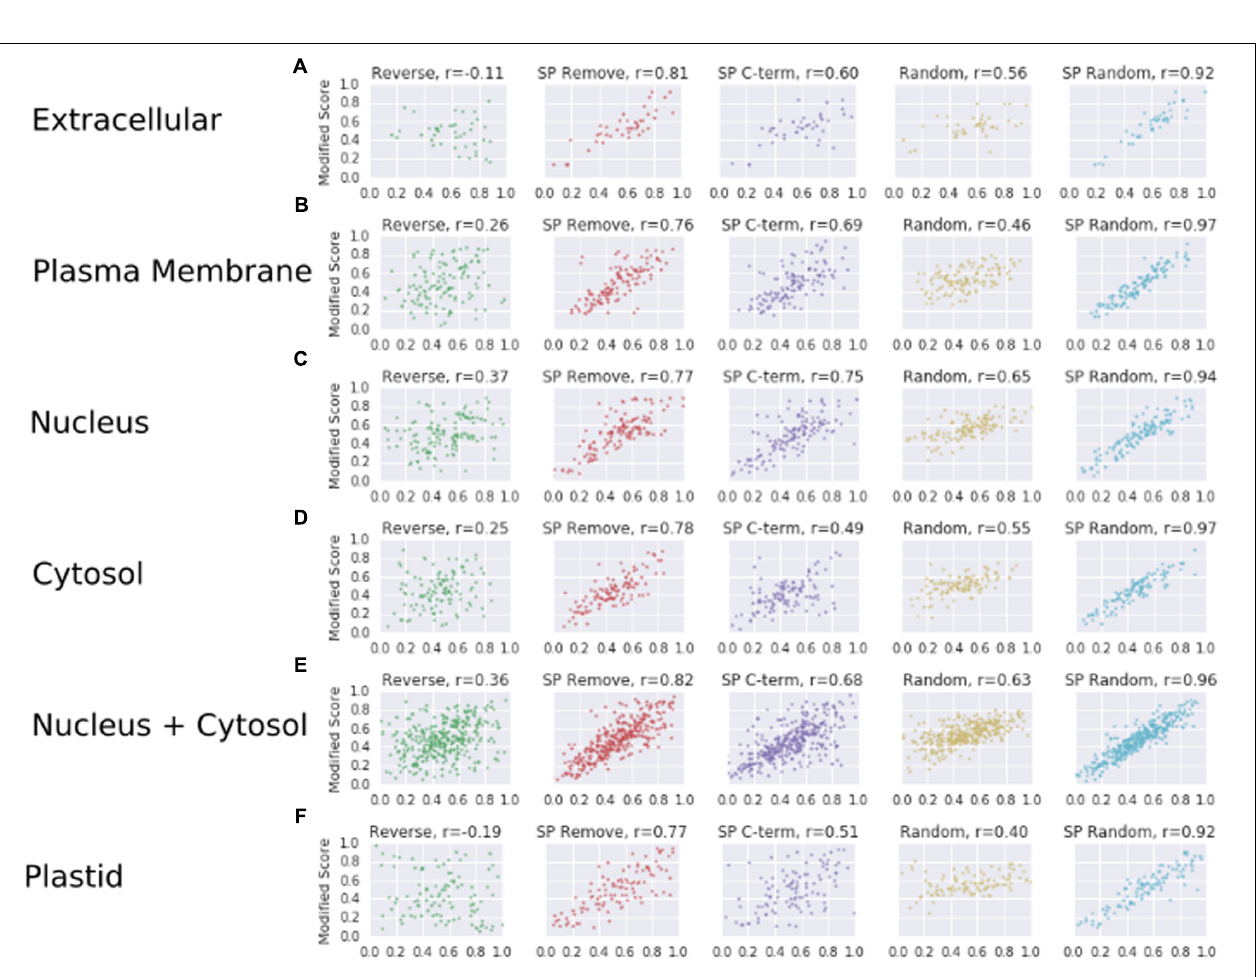
FIGURE 5 | The correlation scores (as described in Figure 3B) for protein sub-sets of ASURE. Extracellular (A) , plasma membrane (B) , nucleus (C) , cytosol (D) , nucleus and/or cytosol (E) , and plastid (F) ,